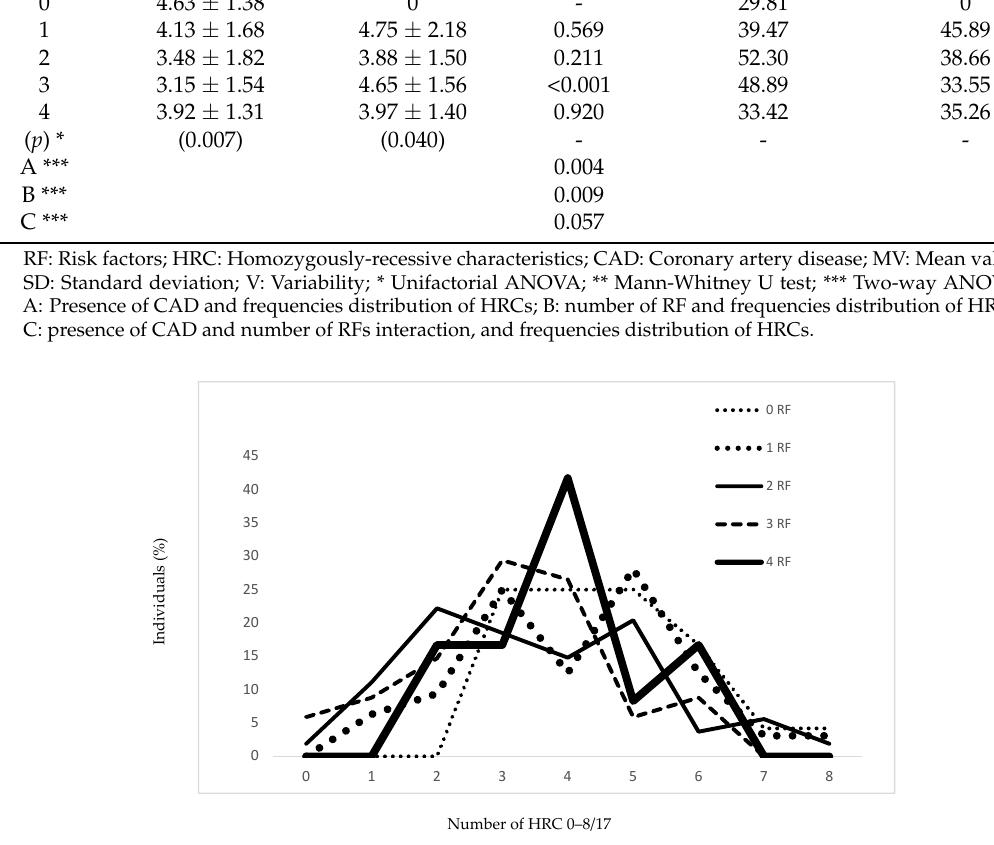
Table 3. Distribution of mean HRC values based on the study of 17 qualitative morpho-physiological traits in CAD patients and control sample regarding presence and number of risk factors.